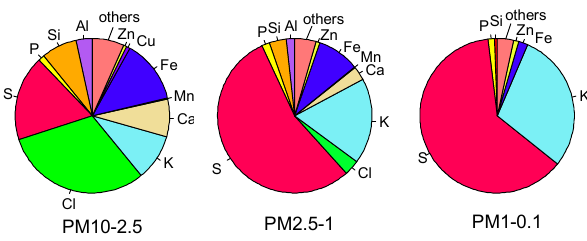
Fig. 10. Pie charts for relative contributions of measured elements in the three size ranges (PM 10 − 2 . 5 , PM 2 . 5 − 1 and PM 1 − 0 . 1 ) from the winter campaign in Z¨urich Kaserne obtained by RDI-SR-XRF trace element